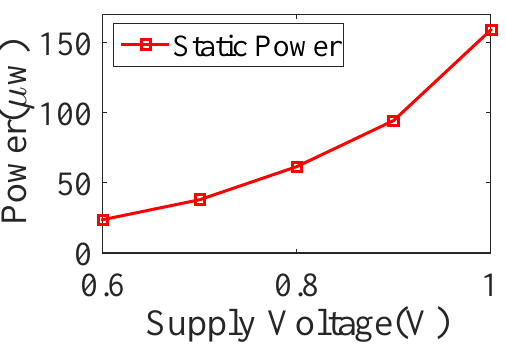
Figure 30. Static power analysis for different supply